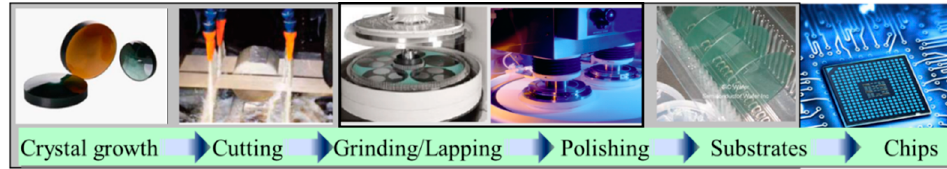
Figure 1. Processing flow of SiC substrates.